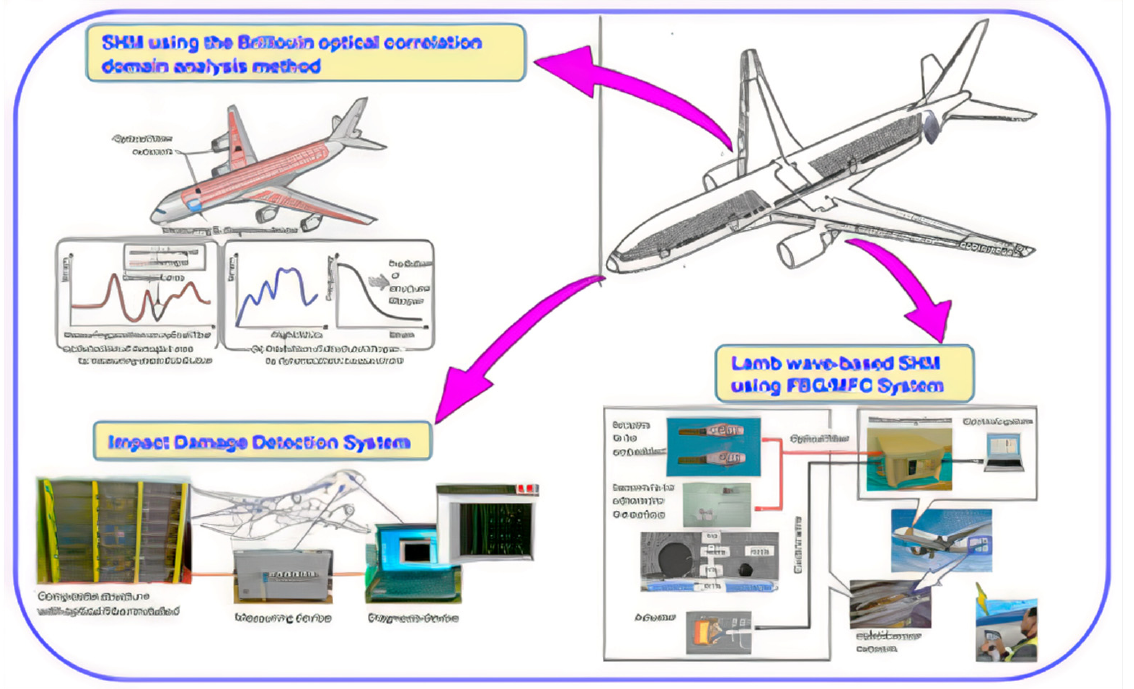
Figure 5. Damage detection alternatives with fiber optic sensors [99]. Reprinted under the Creative Commons (CC) License (CC BY 4.0).